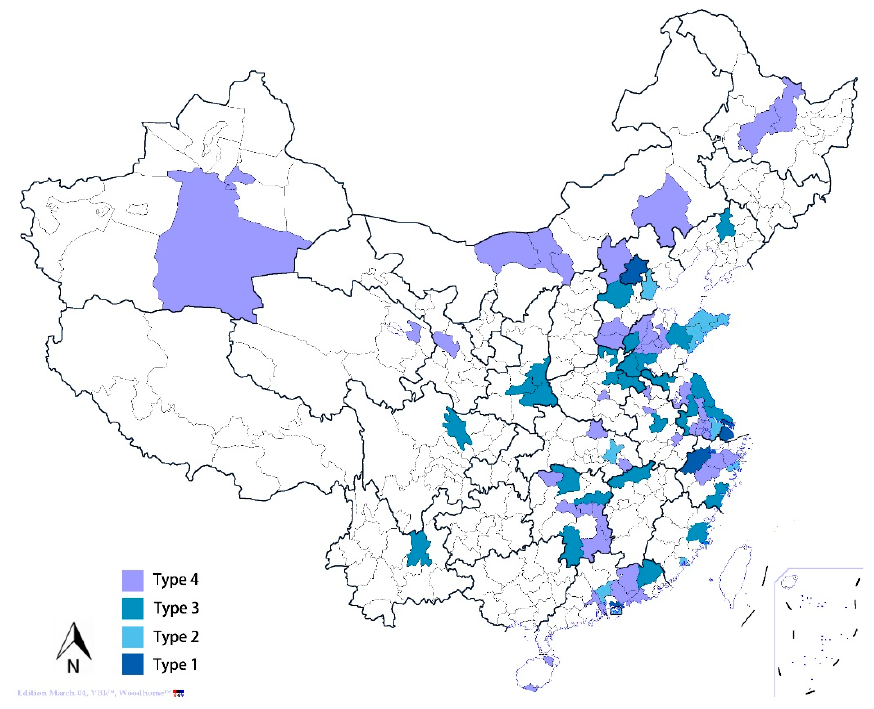
Figure 3. The cluster analysis of different ZIP codes.